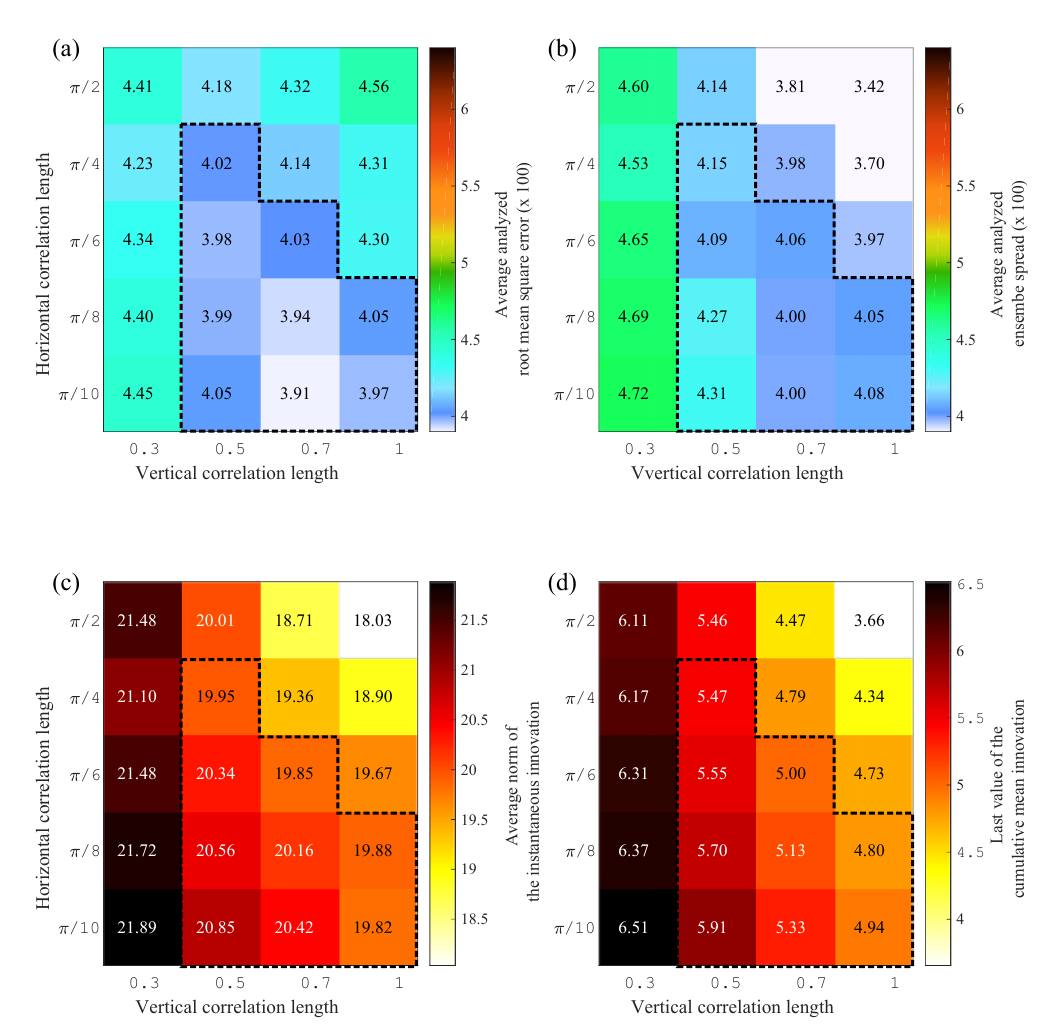
Figure 9. Values of (a) mean analyzed error, (b) mean ensemble spread, (c) norm of instantaneous innovation and (d) norm of cumulative innovation after K = 16 forecasts for N = 288, and different vertical and horizontal correlation lengths. The dashed line delimits the zone ( 288 ) + 0 . 002. for which errors are less than (cid:15) a Tmin minimum of σ a at (cid:96) v = 0 . 7 and (cid:96) h = π/ 10. These parame- T ters correspond to the minimum true error (cid:15) a T